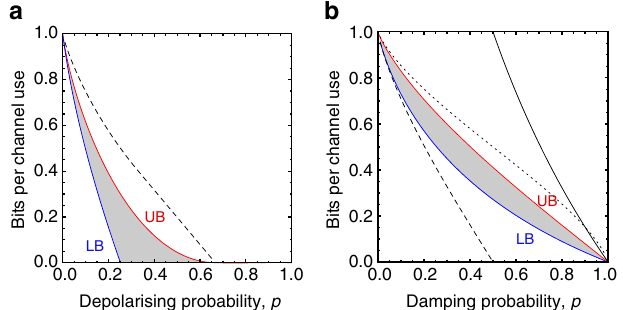
Figure 8 | Two-way capacities of basic qubit channels. ( a ) Two-way capacity of the depolarizing channel P depol with arbitrary probability p . It is contained in the shadowed region specified by the bounds in equation